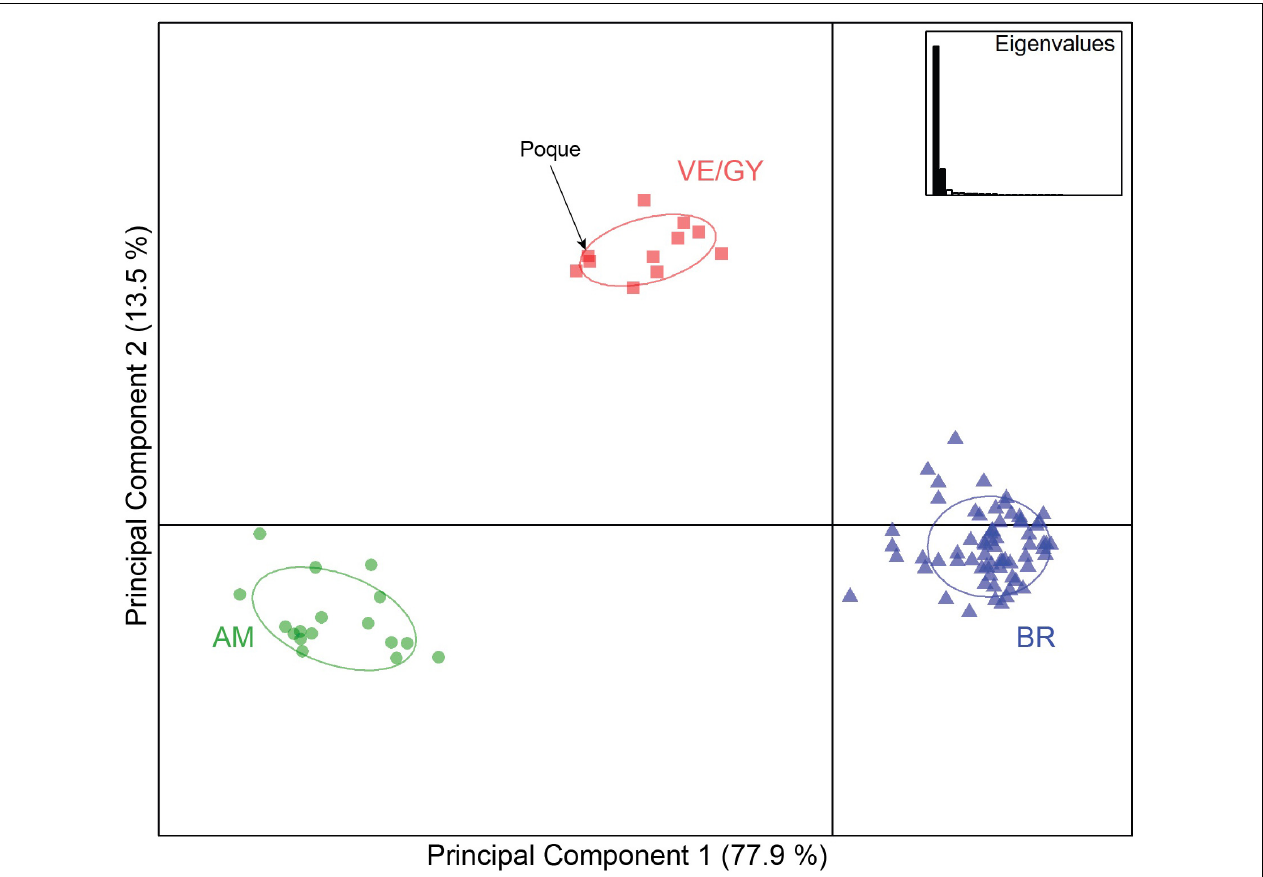
FIGURE 3 | A multivariate Principal Component Analysis (PCA) to visualize the genetic structure using synthetic variables. Circles indicate individuals sampled, colored for the genetic grouping they assigned to, and ellipses around 95% of the variation. Genetic groupings are defined as Venezuela/Guyana (VE/GY), Amazonian (AM), and Brazil (BR).